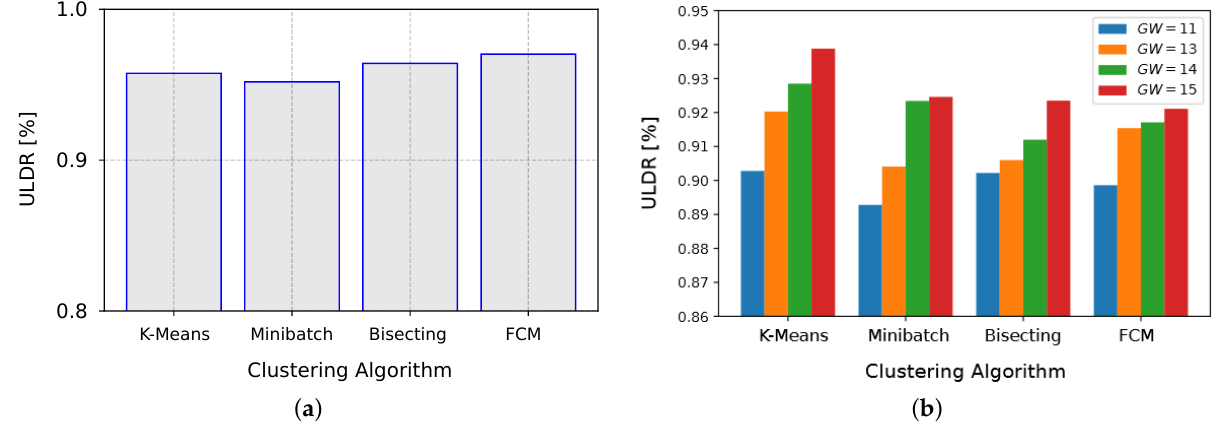
Figure 8. ULDR obtained by the method considering ( a ) Scenario 1, and ( b ) Scenario 2. By analyzing the ULDR values in Figure 9, it can be seen that they improved as the number of GWs increased, for both Scenario 1 and 2; this behavior was expected, as less energy was needed for the EDs to transmit their messages, increasing the SIR (signal-to- interference ratio) and, consequently, reducing packet loss. The Scenario 1 impairment was dominated only by noise, while Scenario 2 impairments were also dominated by collisions and interference. Comparing both scenarios, it can be seen that the ULDR performance improved faster in Scenario 1—that is, with fewer GWs—than in Scenario 2, because of the amount of deterioration